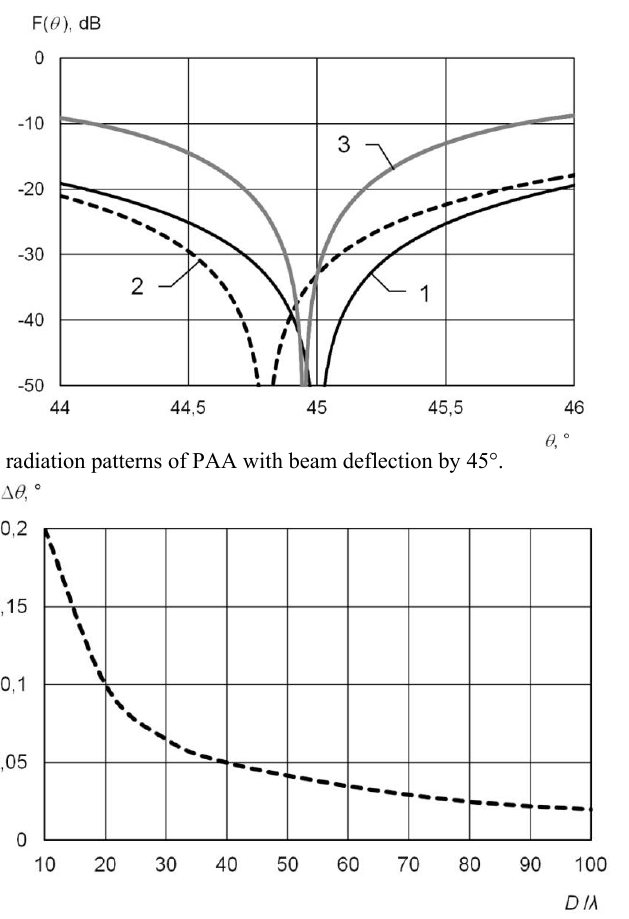
Fig. 4. The value of the angular displacement of the difference radiation pattern minimum depending on the diameter of the PAA aperture.